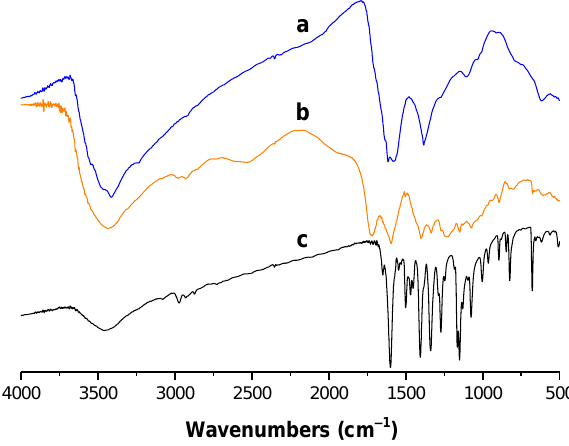
Figure 4. FTIR spectra of ( a ) potassium humate, ( b ) HS–BB 3 complex and ( c ) BB 3. The HS and dye interaction is clearly depicted in Figure 4b. The complex formed displays peaks corresponding to both C.I. Basic Blue 3 and potassium humate in the HS–BB 3 FTIR spectrum. Dye–humics complexation imparts significant changes in the spectrum (Figure 4b) that involve the shift in the 1385 and 1575–1625 cm − 1 peaks in Figure 4a, as well as a shift in the wavelength and a reduction in the intensity of the dye peak at around 1600 cm −1 (Figure 4c). Strong absorption bands attributed to both aryl and alkyl C – N stretches in Figure 4c are decreased in intensity and shifted, which is also true for the peak at 1165 cm −1 , certain indications that N atoms (not attached to the oxazine ring) and O atoms are the two most probable sites of dye – humics interaction. This is to be expected, as these atoms in the resonance structures of the dye shown in Figure 1 can bear positive charges and attach to the carboxyls that occur on humates. 3.2. Dye Adsorption Figure 5 illustrates the HS concentration-dependent spectra of HS – BB 3 mixtures in the presence of different HS loadings. From Figure 5, we assume that the dye absorbance at 654 nm decreases with increasing concentration of potassium humate. In addition, two isosbestic points are observed at 568 and 669 nm, both accounting for HS – BB 3 complex- ation. Apart from the drop in absorbance at λ max (654 nm), the HS – BB 3 binding reaction induces an increase in absorbances at wavelengths greater than 669 nm and lower than 568 nm, as well as modifications in the shape of the absorption curve in the UV region. Changes in the spectrum at wavelengths of 568 nm or less denote alterations in the dye conjugation due to complexation [27]. It is also evident from Figure 3 ( A = 0.04 – 0.06 at a concentration of 20 mg L − 1 ) that HS absorb only weakly within the range of 620 to 670 nm in which the main absorption peak of the dye lies (Figures 2 and 5). The peaks at 261 and 297 nm shown in Figure 5 are consistent with π → π* and n → π* transitions of both aro- matic rings attached to the oxazine group and to the secondary amines. In order to fully understand the nature of the HS – BB 3 interactions, spectra were rec- orded using very low dye loadings (from 0.4 × 10 −3 to 2 × 10 −3 g L −1 ) with respect to the